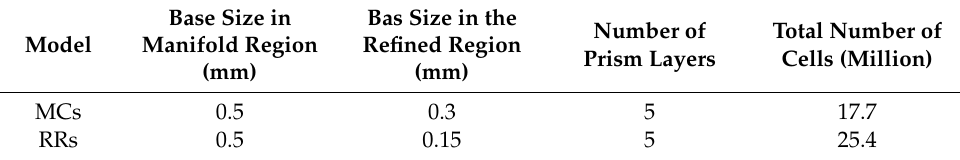
Table 1. Topological details of the computational grids developed for the MC and RR